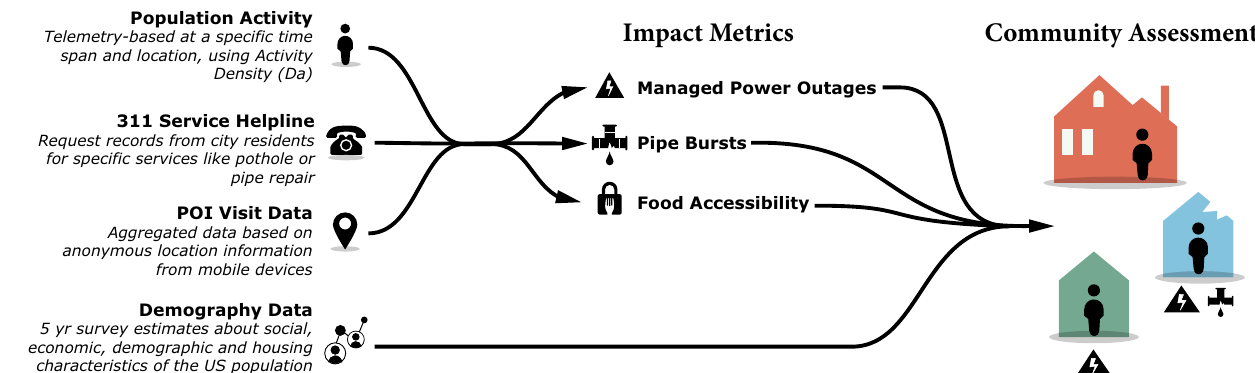
Fig. 1 Schematic of the study to assess the impact of Winter Storm Uri. We gathered and aggregated data of population activity, point-of-interest (POI) visits, 311 service helpline calls, and demographic information from several data sources to assess community impacts related to the winter storm-induced power outages, burst pipes, and